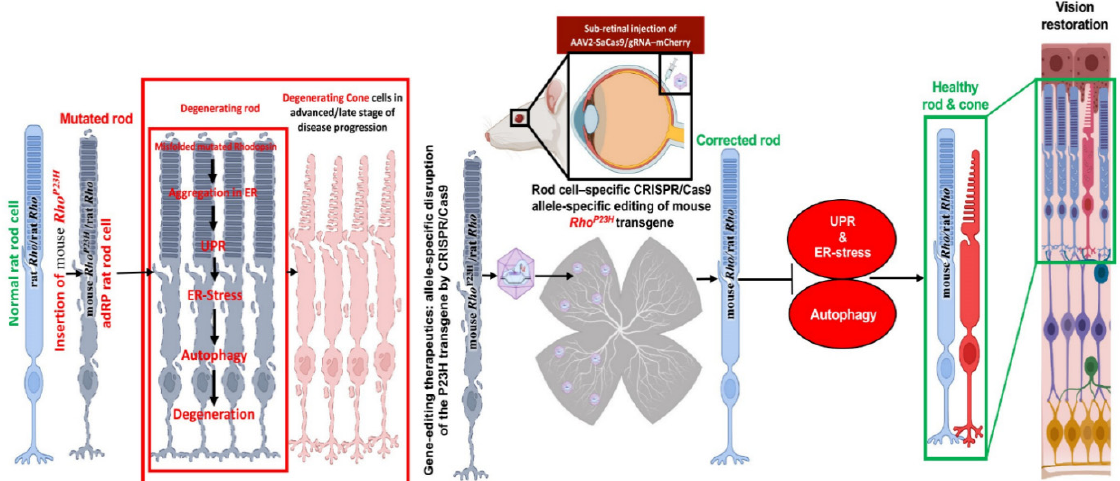
Figure 3. Schematic representation of CRISPR/Cas9 editing in the Rhodopsin P23H to restore and rescue long-term vision in mice [82].